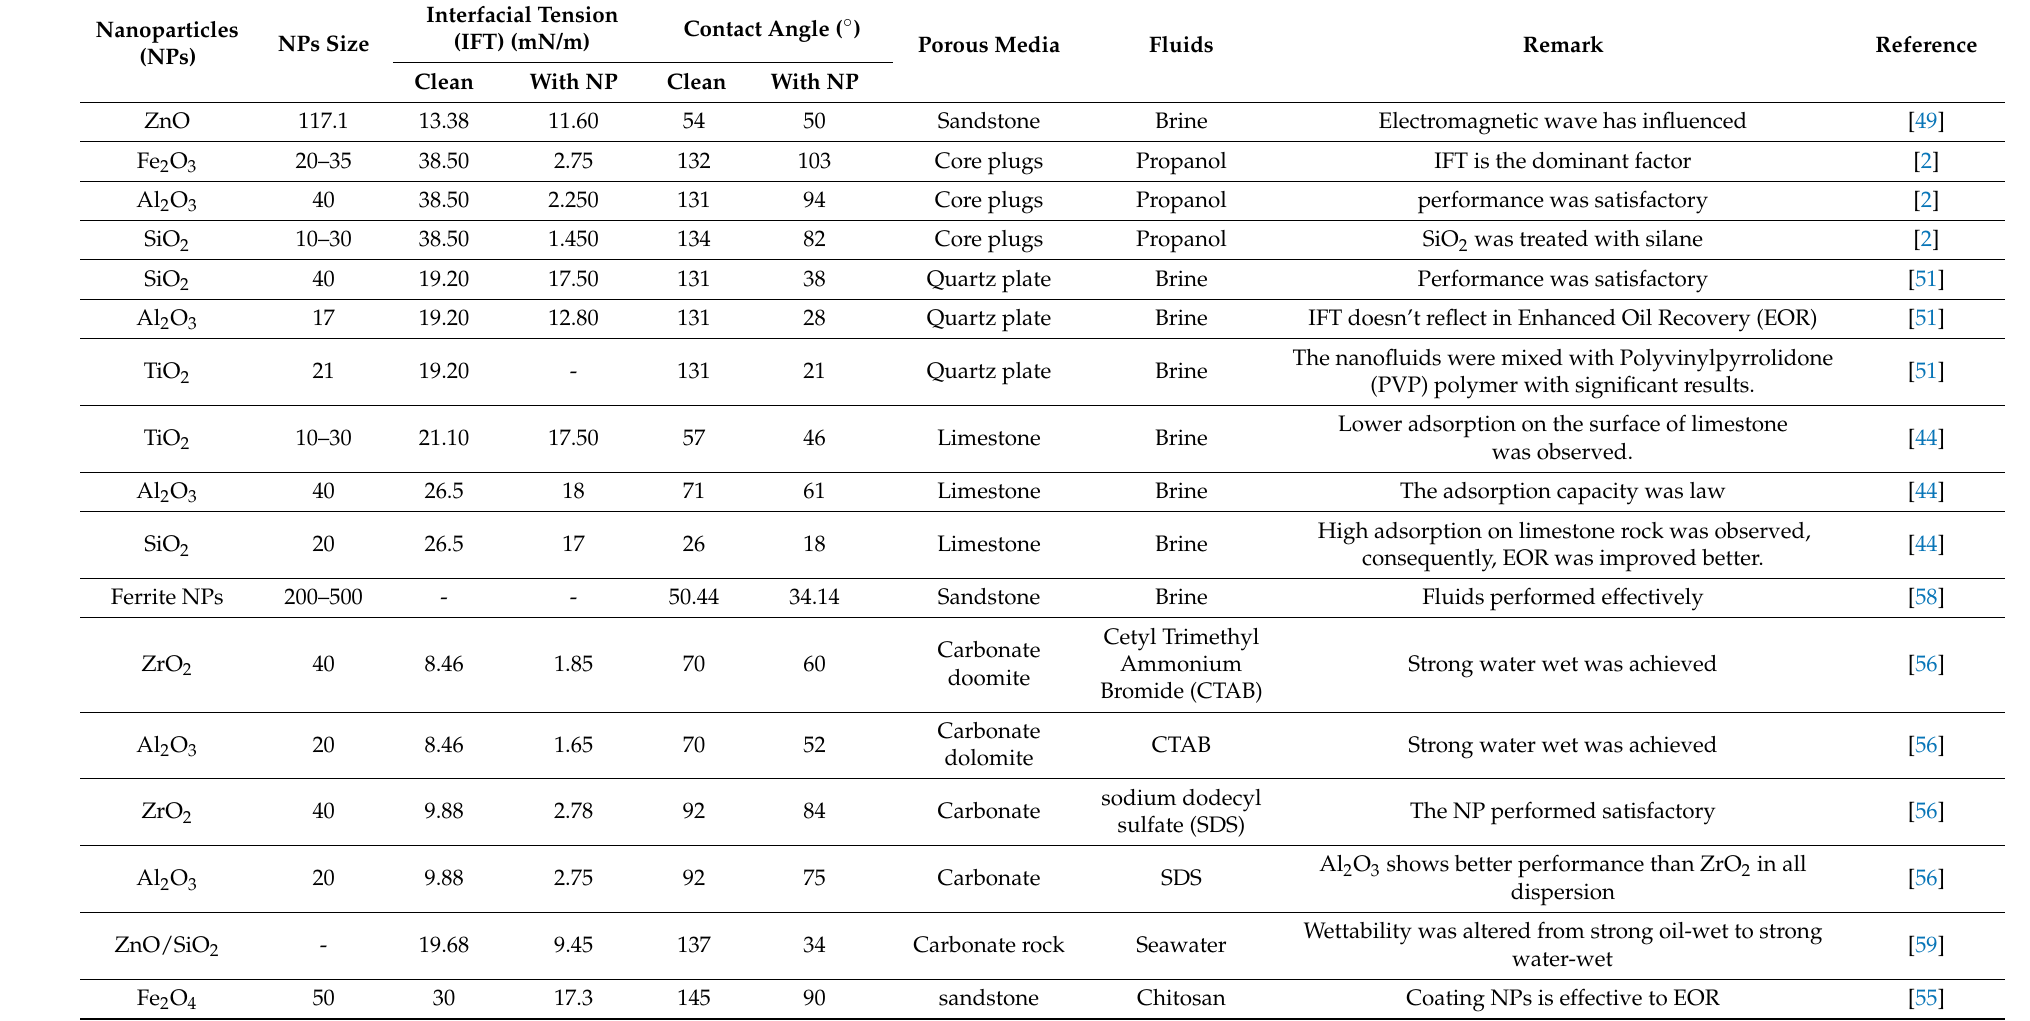
Table 1. Summary of the effects of Nanoparticle on Interfacial tension (IFT) and wettability